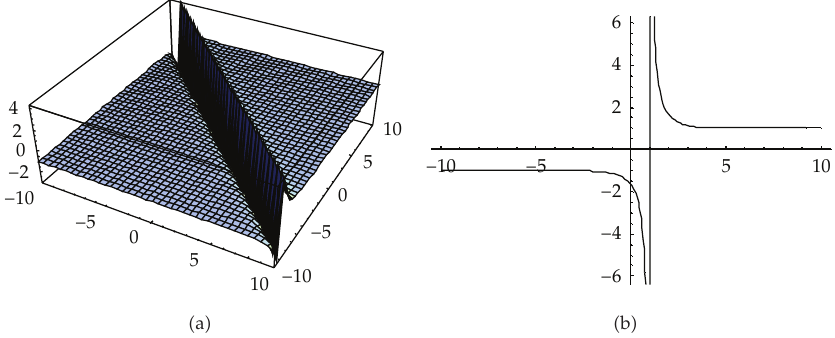
Figure 2: (cid:3) a (cid:4) The graph of (cid:3) 3.10a (cid:4) with a (cid:8) r (cid:8) σ (cid:8) 1 ,b (cid:8) 2 at t (cid:8) 1 and (cid:3) b (cid:4) is its plane when y (cid:8) 0 (cid:3) the case is the same to (cid:3) 3.8 (cid:4) when m (cid:8) 1 (cid:4)